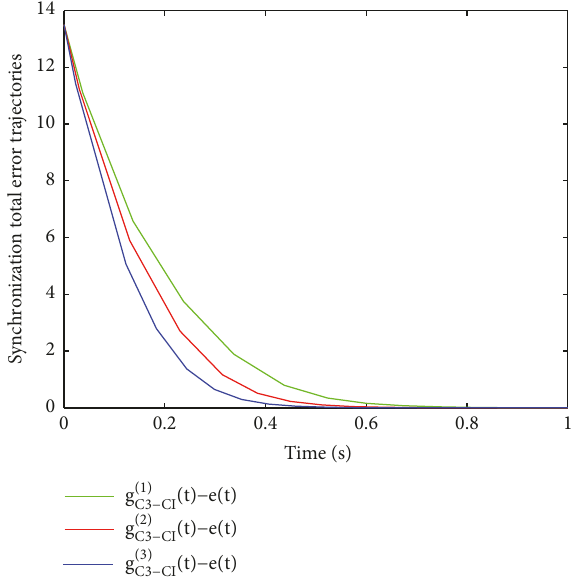
Figure 4: Synchronization total error trajectories of the network (36) for the case II of Corollary